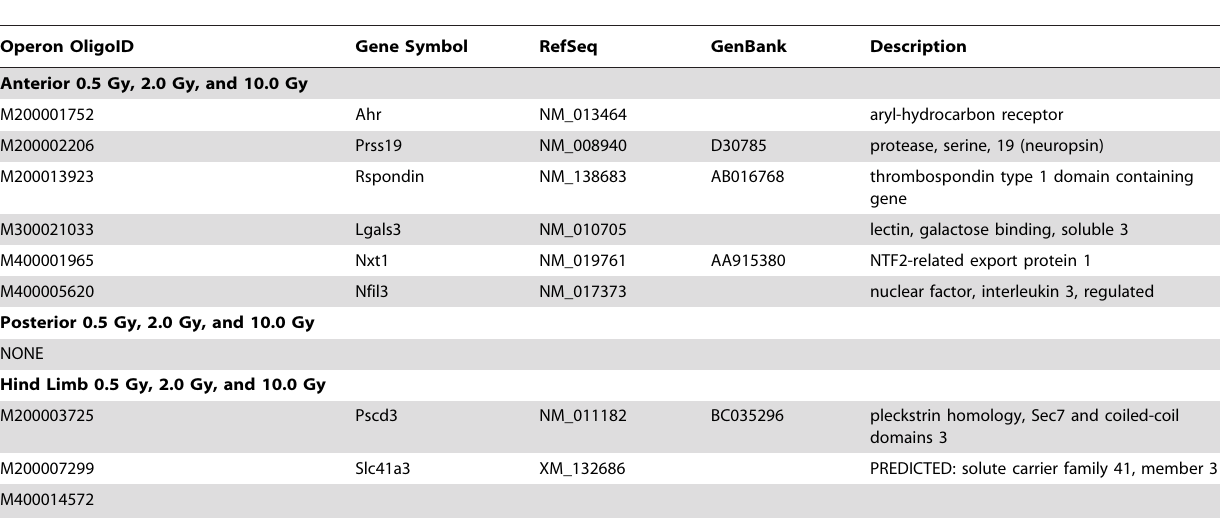
Table 1. Overlap genes between 0.5, 2.0 and 10 Gy dose levels in partially irradiated mice.